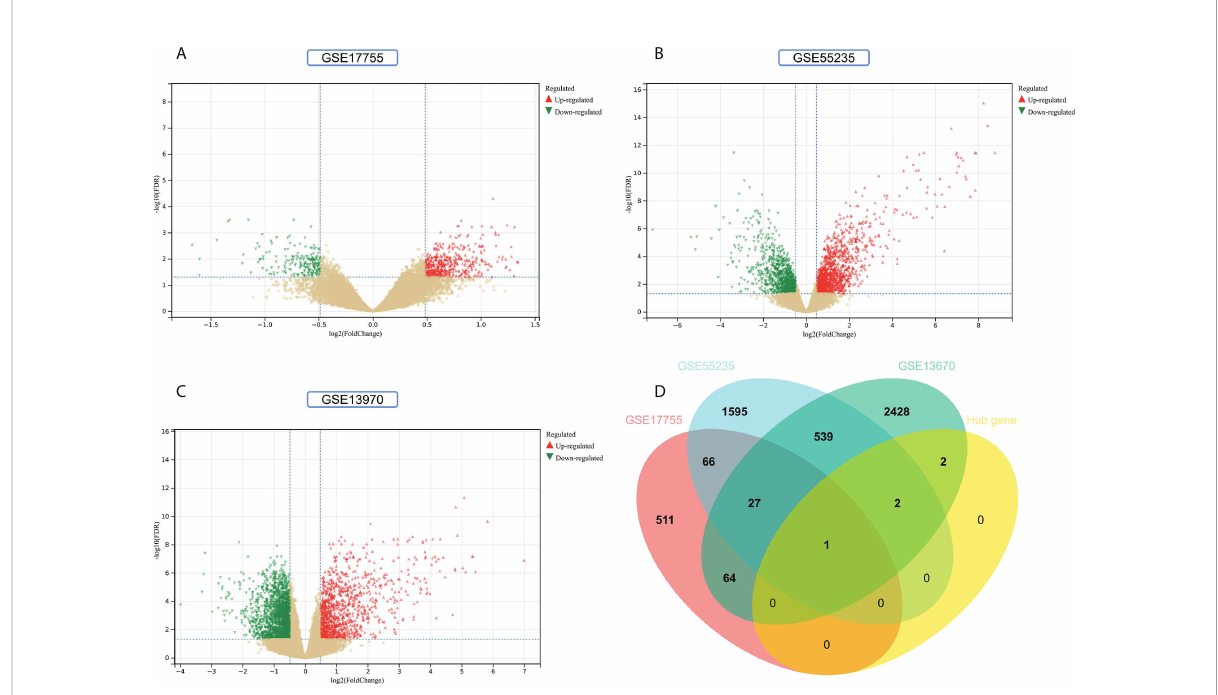
FIGURE 11 Screening for key genes. (A, B) Gray dots represent genes not substantially differently expressed in RA and HC groups ( P > 0.05), red triangles represent upregulated genes ( P < 0.05), and green triangles represent downregulated genes ( P < 0.05) in GSE17755 and GSE55235 datasets. (C) Gray dots represent genes not substantially differently expressed in S. aureus and HC groups ( P > 0.05), red triangles represent upregulated genes (P < 0.05), and green triangles represent downregulated genes ( P < 0.05) in the GSE13670 dataset. (D) The Venn diagram of fi ve hub genes with the three validation sets of DEGs.